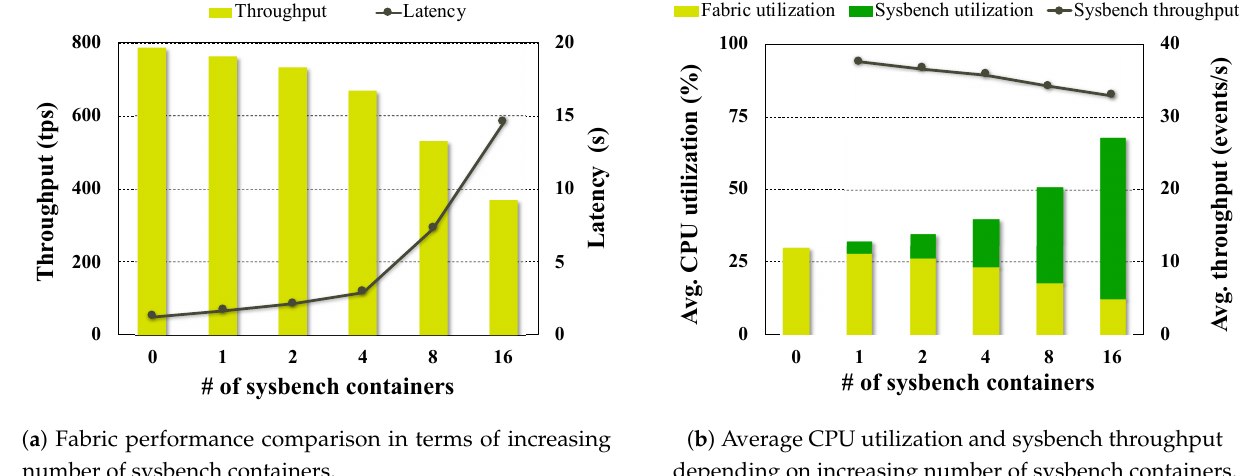
Figure 3. Impact of co-located tasks on